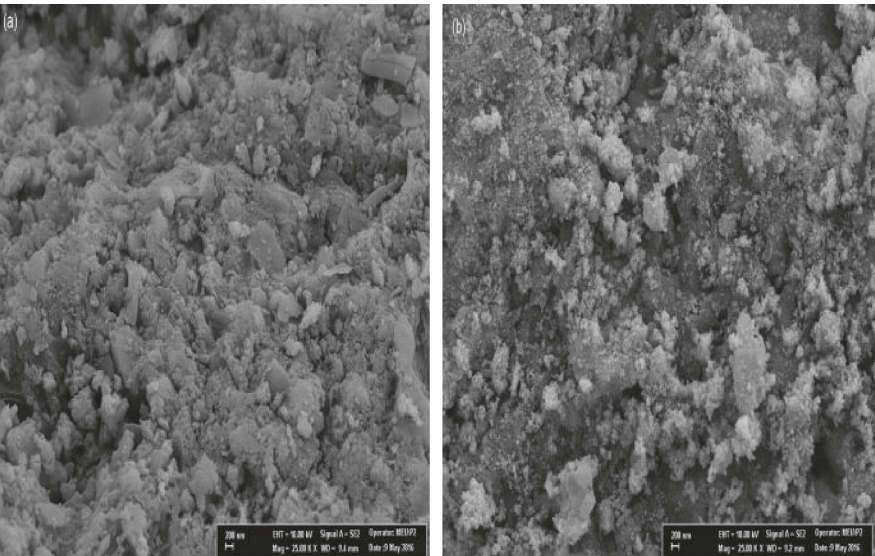
Figure 1: SEM images of raw biochar (RB) and iron-modified BC (FMBC).